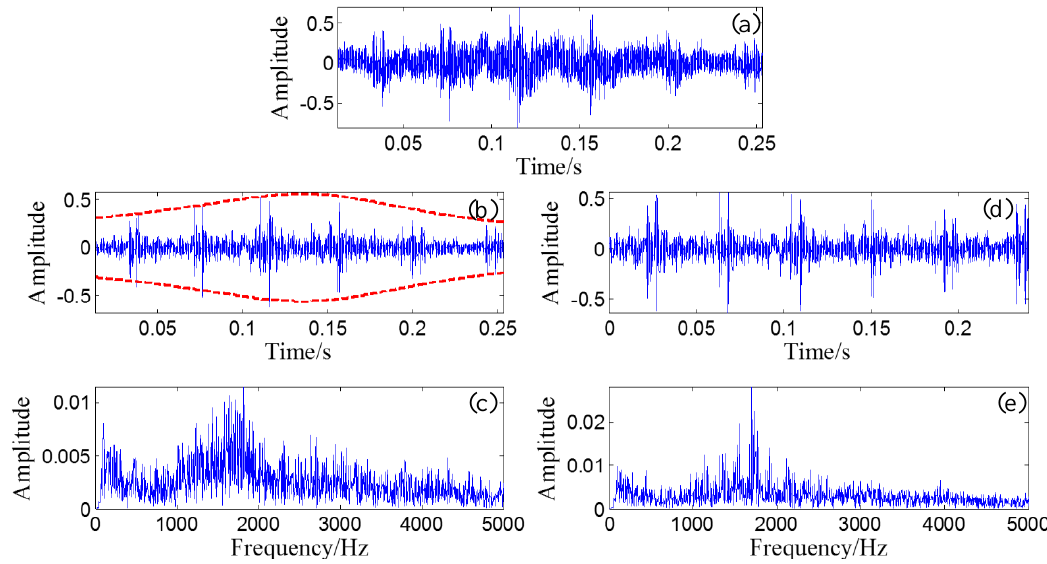
Figure 21. ( a ) Waveform of the Doppler-shifted signal with the inner-race defect; ( b ) waveform of the filtered Doppler-shifted signal with the inner-race defect and ( c ) its FFT spectrum; ( d ) waveform of the Doppler-free signal with the inner-race defect and ( e ) its FFT